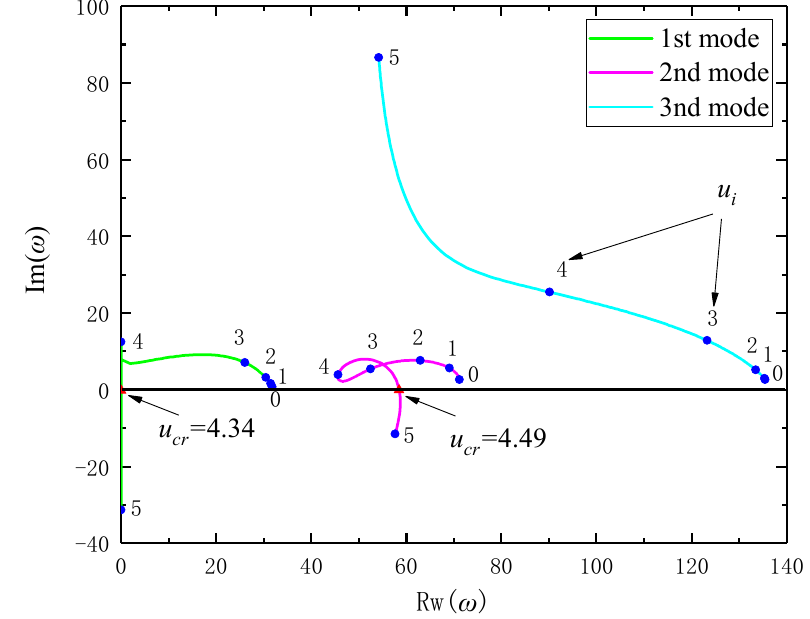
Figure 7. Argand diagram of the dimensionless complex eigenfrequencies of the leaching-tubing-like system, as a function of the nondimensional internal flow velocity u i for α ch = 1.20. Blue solid circles represent the nondimensional internal flow velocity u i . Red solid triangles represent the critical flow velocity when flutter instability occurs in the corresponding mode.